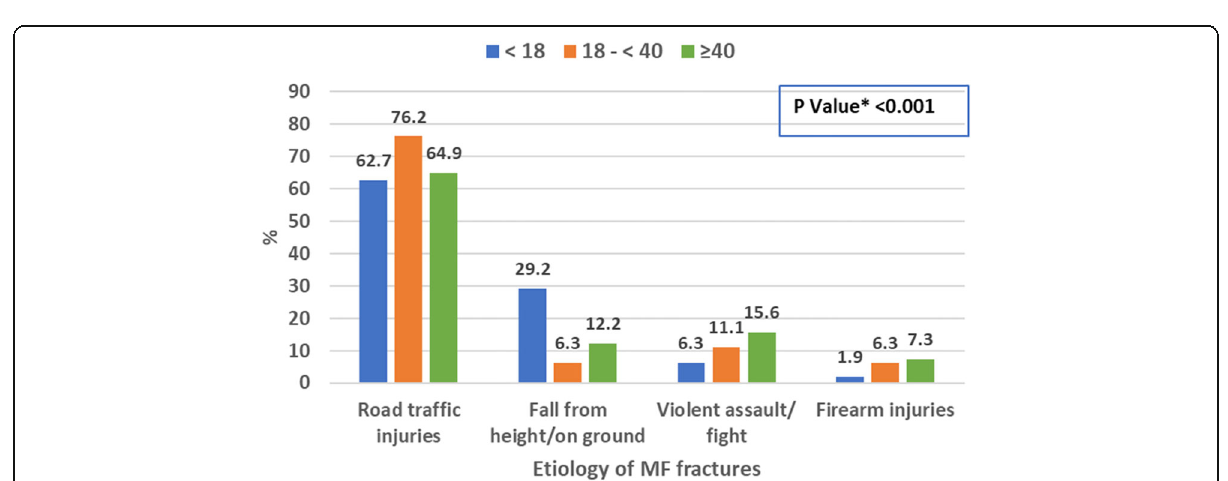
Fig. 2 Etiology of craniomaxillofacial fractures regarding age distribution in the studied sample. *Chi-square test